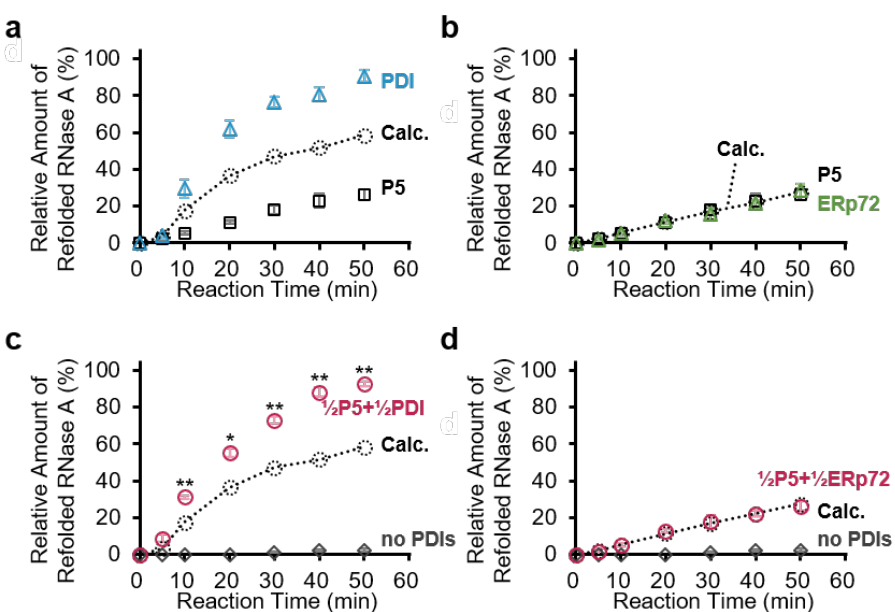
Figure 3. P5 acts in concert with PDI to synergistically accelerate oxidative folding of RNase A. ( a – d ) Reduced and denatured RNase A (16 µM) was incubated without PDIs ( no PDIs ), with 1.0 µM P5 ( a , b ), 1.0 µM PDI ( a ), 1.0 µM ERp72 ( b ), a mixture of 0.5 µM P5 and 0.5 µM PDI ( ½P5+½PDI ) ( c ), or a mixture of 0.5 µM P5 and 0.5 µM ERp72 ( ½P5+½ERp72 ) ( d ), and cCMP hydrolysis by refolded RNase A was measured. The ratio of refolded RNase A was calculated from the relative rate compared with the reaction rate of native RNase A. Error bars indicate the means ± SEM of three independent experiments. Calc. , calculated arithmetic means of the relative rates of P5 alone and PDIs alone (dotted line and circle). *, p < 0.05; **, p < 0.01, statistical significance between the mean of